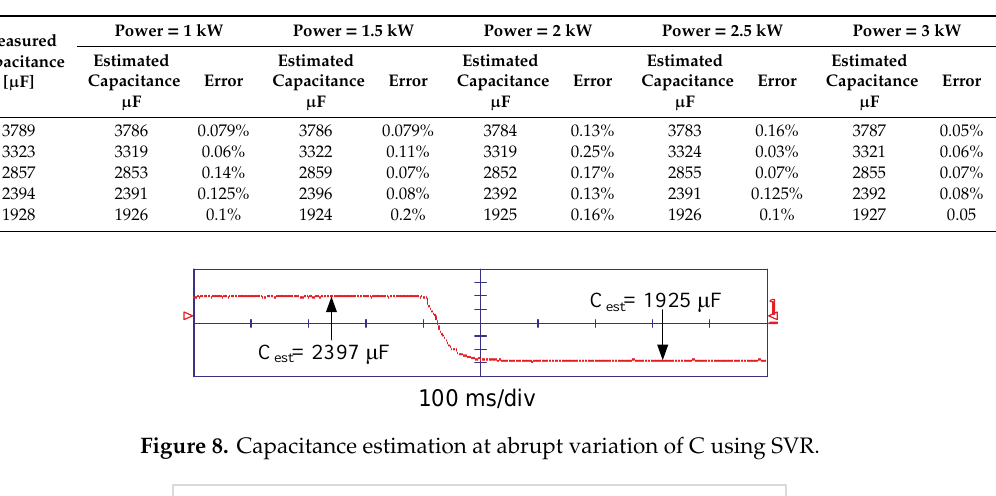
Figure 7. Capacitance estimation at abrupt variation of C using particle swarm optimization-based support vector regression (PSO-SVR). Table 4. Real-time monitoring of DC-link capacitor for di ff erent input power.